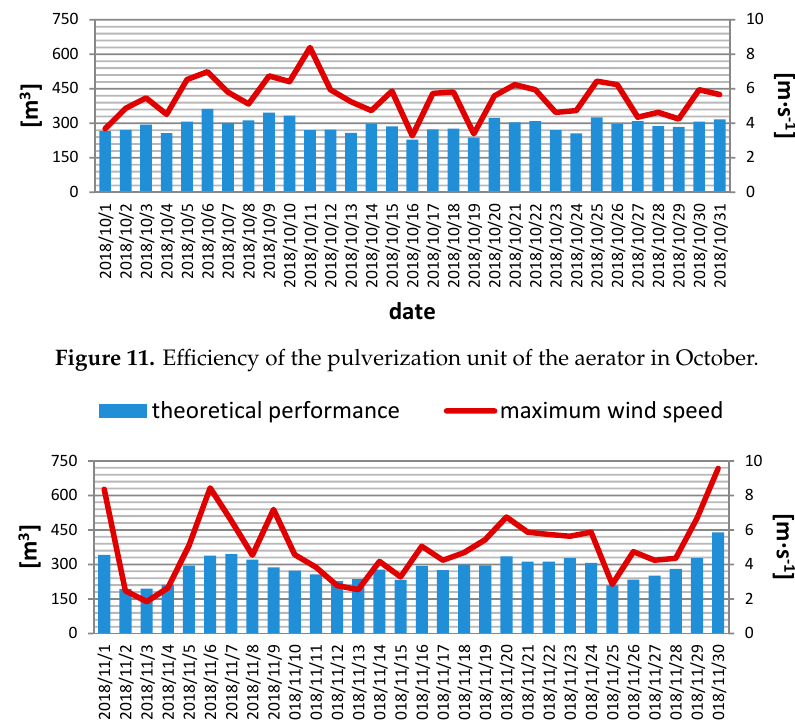
Figure 10. E ffi ciency of the pulverization unit of the aerator in September. Figure 10. Efficiency of the pulverization unit of the aerator in September.